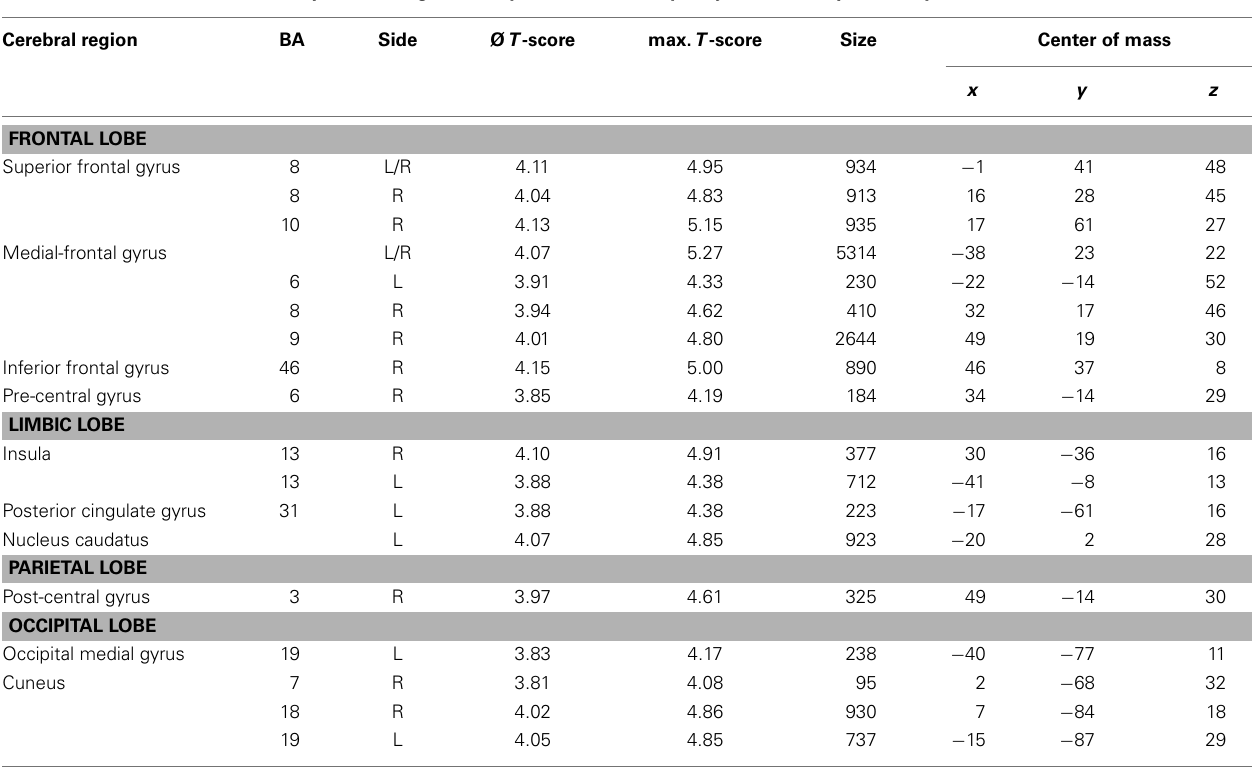
Table 3 | Single-trial analyses: N2-related BOLD activity; areas that showed higher BOLD activity in healthy subjects compared toADHD patients during voluntary selection tasks [ q (FDR) < 0.01; T = 3.68–8; cluster size > 30Voxel] . BOLD response during voluntary selection: healthy subjects > ADHD patients: q (FDR) < 0.01